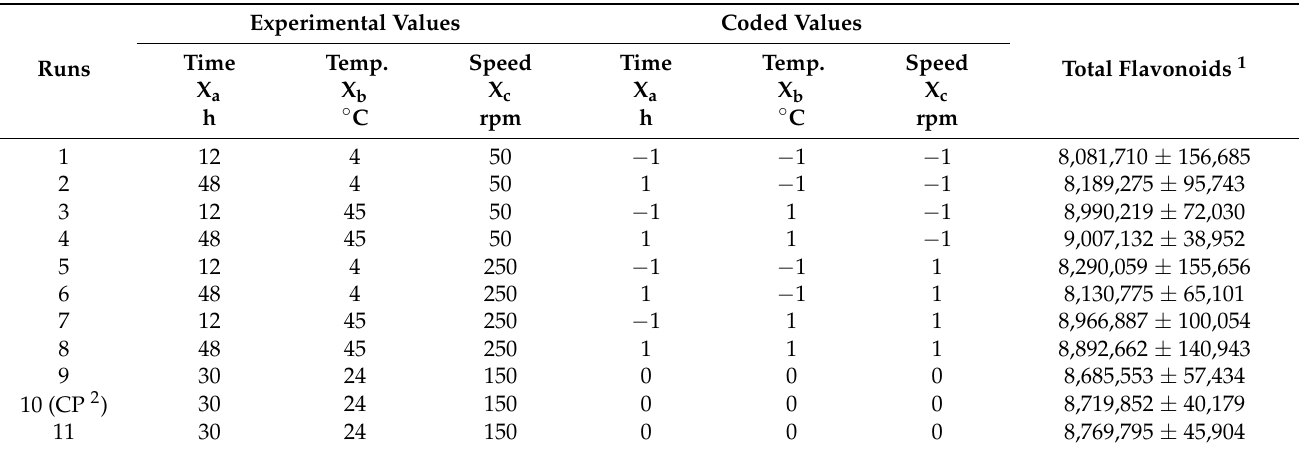
Table 3. Matrix of 2 3 FFD and experimental data for optimization of flavonoids shaking extraction